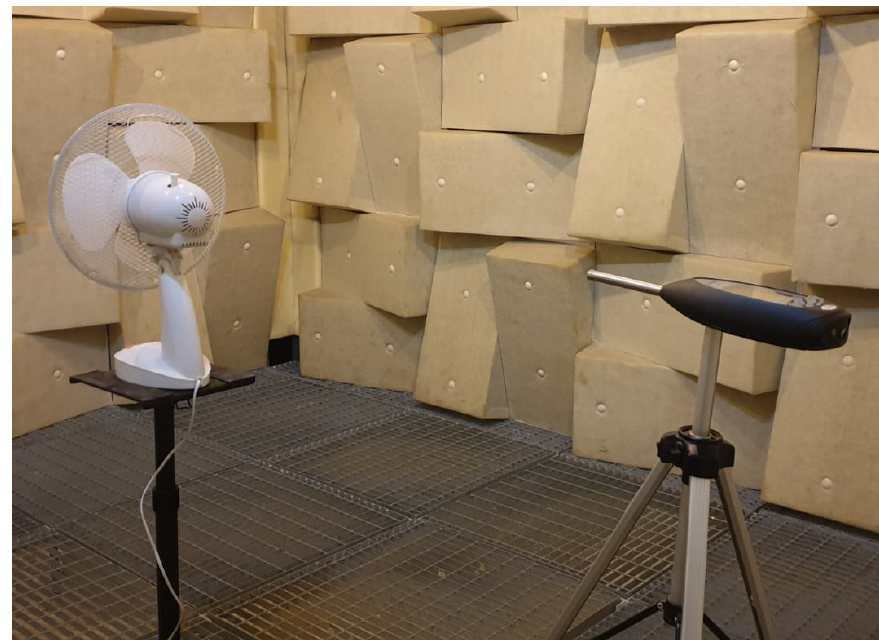
Figure 3. Set up of measurements in an anechoic chamber. The decision to place the sound level meter behind the fan was made to avoid the influence of the air flow on the measurement. The Class 1 integrated sound level meter model 01 dB Black Solo that complies with UNI EN ISO 3745:2012 was used to conduct the acoustic measurements [56]. The